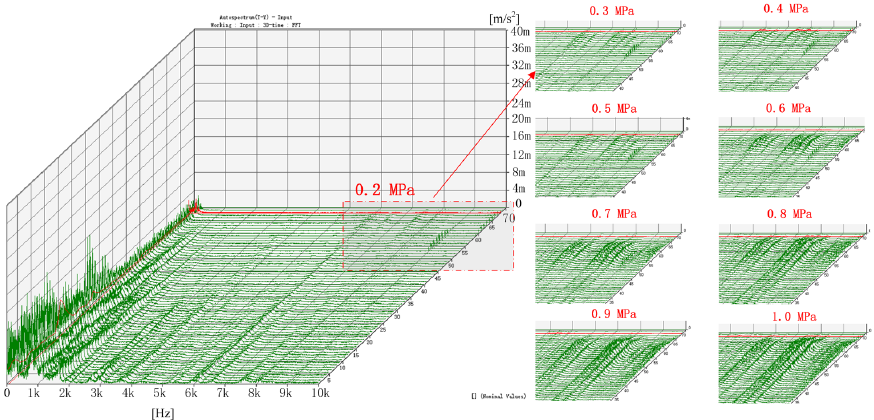
Figure 10. Effect of the specific pressure on the frequency-domain diagram of the test bearing in the Y direction.